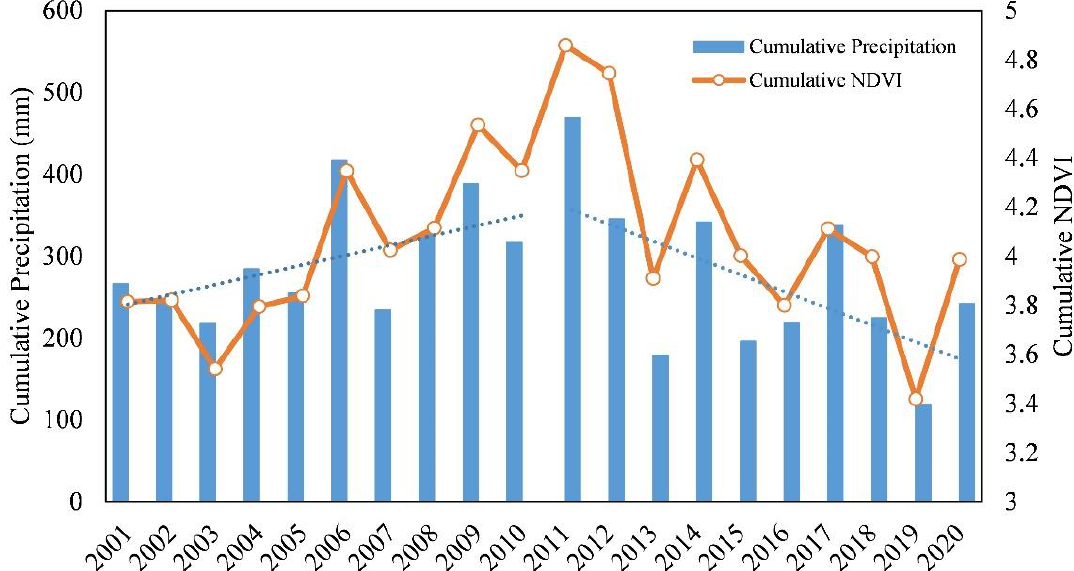
Figure 2. Inter-annual variation of cumulative precipitation and cumulative NDVI during the growing season (September to the following April) in Namibia between 2001 and 2020.